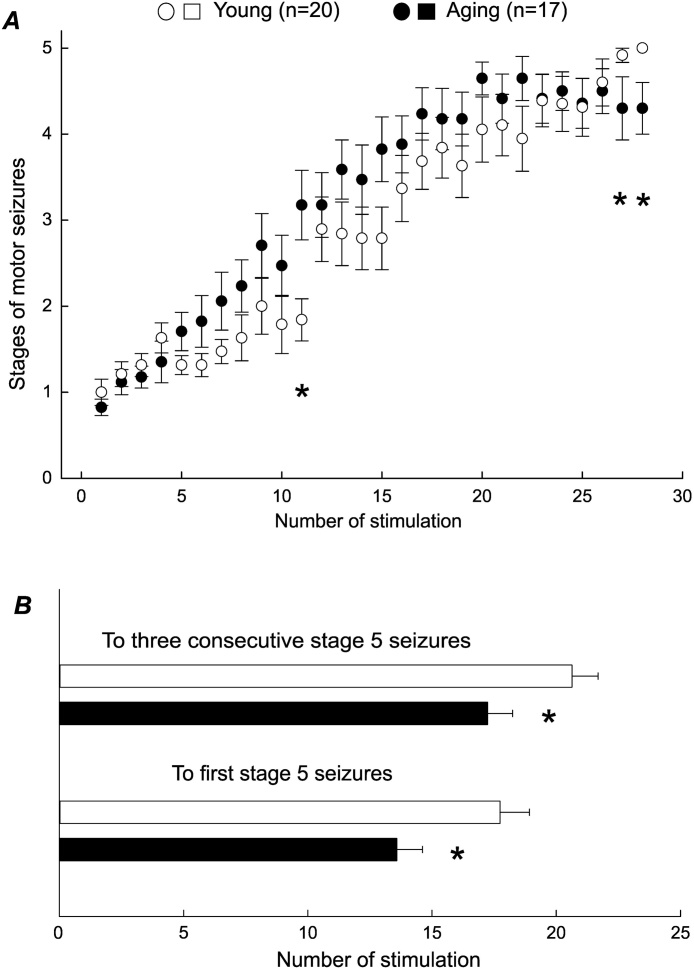
Motor seizure progression in the aging and young mice.A, plots of motor seizure stages vs. numbers of hippocampal stimulation were generated for young and aging mice. B, numbers of hippocampal stimuli to evoke the first stage 5 seizures (bottom) or stage 5 seizures over three consecutive days (top) were determined in individual animals. Here and in subsequent figures, only the stimulations that evoked AD and corresponding responses were analyzed; where the stimulations that failed to evoke AD were excluded from data analysis. Mean and SEM were presented for all data points and significant differences were denoted by * (p < 0.05, Student’s t-test or Mann-Whitney Rank Sum Test) in this and subsequent figures.